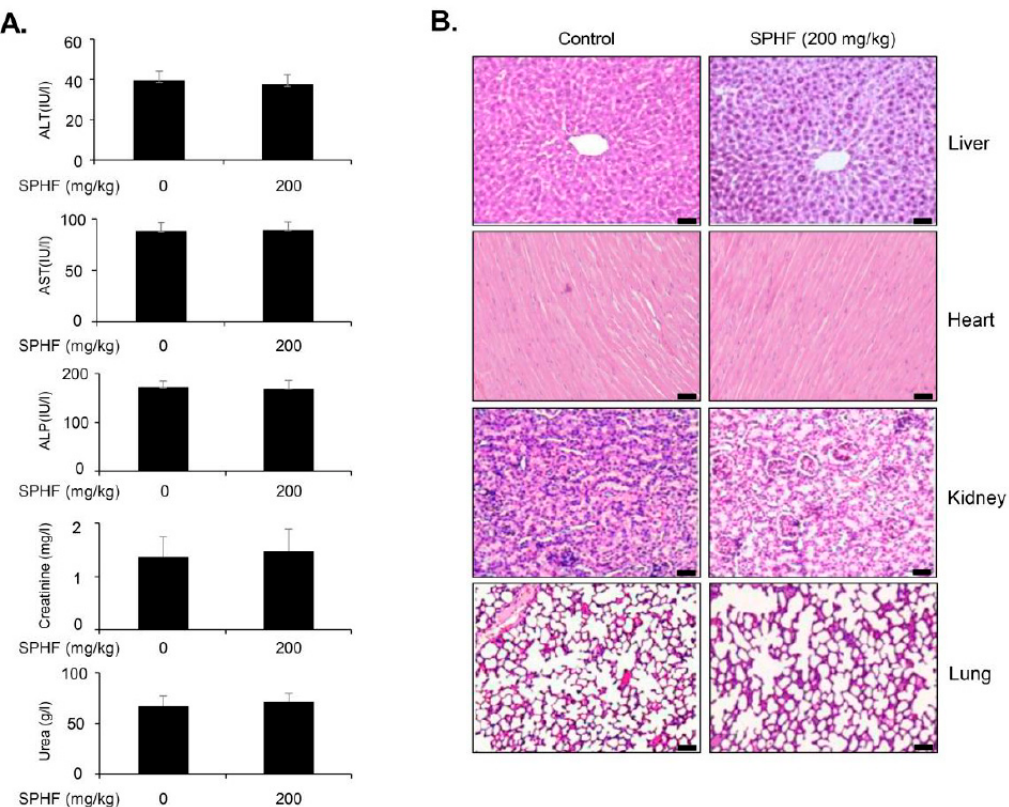
Figure 6. E ff ect of SPHF on biochemical parameters and H&E staining in EJ cell xenograft mice. ( A ) Biochemical factor (AST, ALT, ALP, urea, and creatinine) levels were estimated in SPHF-treated and non-treated xenograft mice. ( B ) Photomicrograph analysis of H&E staining in major organs (liver, kidney, lung, and heart, scale bars = 50 µ